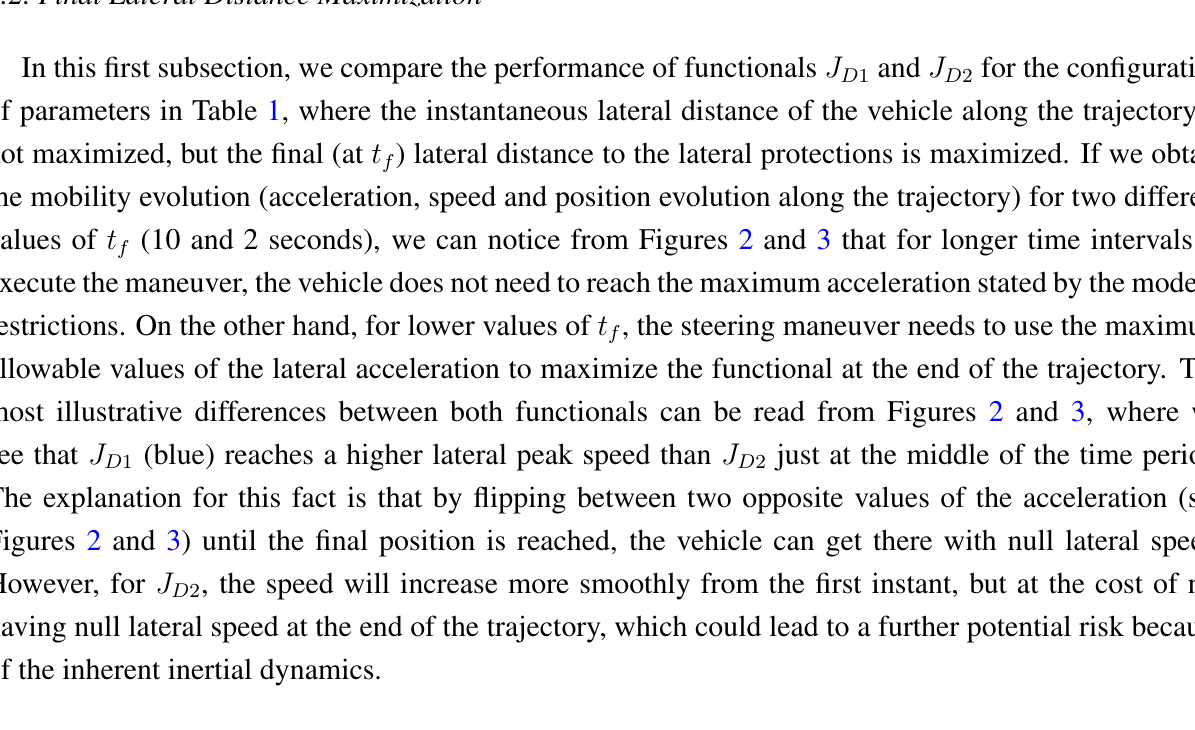
Table 1. Configuration parameters and values for all